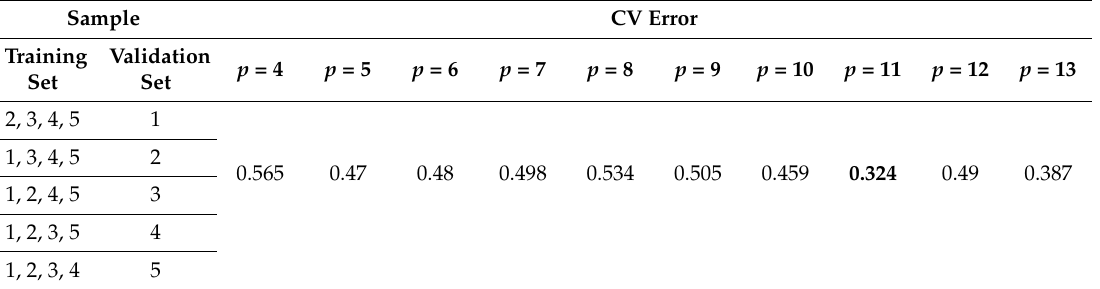
Table 3. K-fold cross-validation (CV) results.